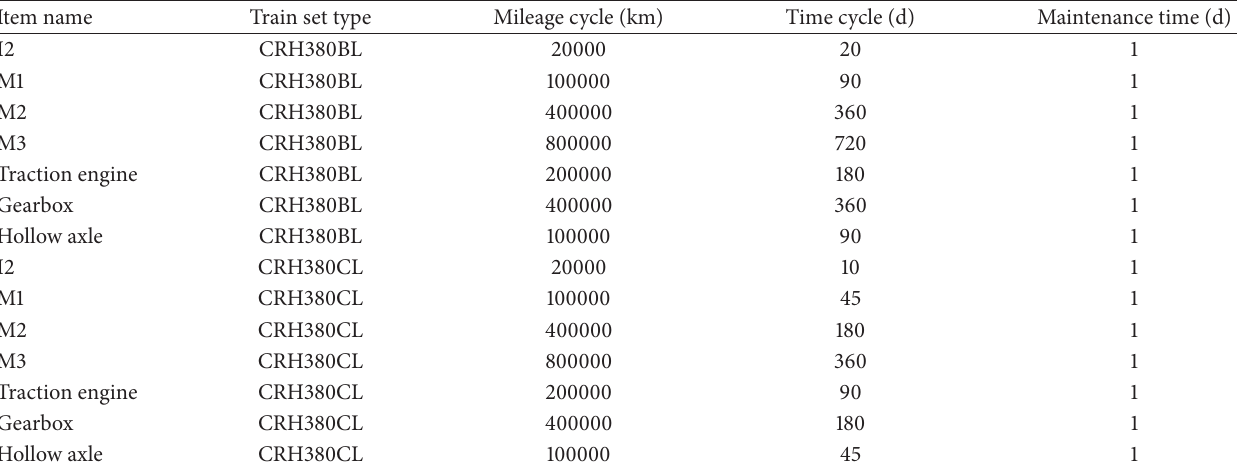
Table 3: Basic information of maintenance items.